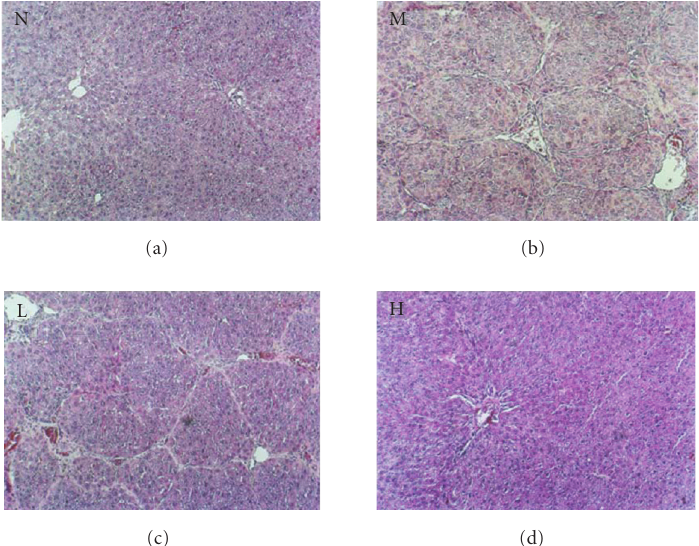
Figure 2: Liver histopathology of the rat detected by HE staining. N represented the normal control group; M represented the model group; L represented the group treated with low dose of thalidomide; H represented the group treated with high dose of thalidomide (original magnification N, M, L, H, × 100).